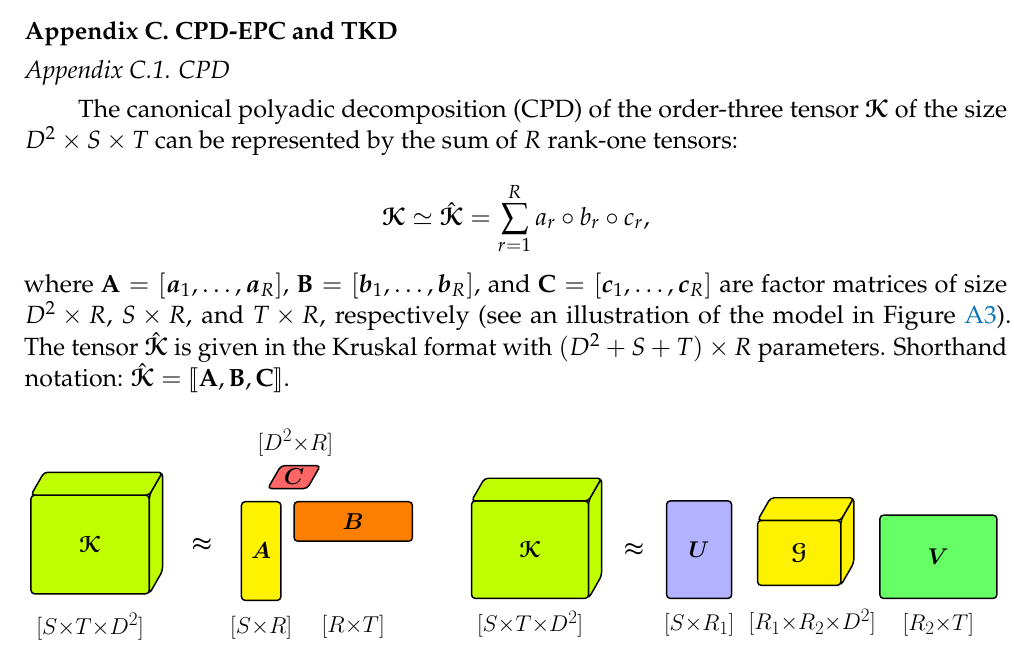
Figure A2. The mean and maximum are taken over channels for the MAE/cosine distance/bias between outputs of BN layers subsequent to the original and decomposed layers. Bias is the difference between outputs’ means. In the Single setting, the compressed model has only one decomposed layer, while in the Joint setting, three layers are simultaneously decomposed. W/O corresponds to the case without calibration of the BN statistics, while W corresponds to the case with calibration of the BN statistics. The X-axis shows the CP rank. Note: for the first decomposed layer, layer1.1.conv1 (left subfigure), the results of the Single and Joint settings coincide. ( a ) Mean of the MAE. ( b ) Mean of the cosine distance. ( c ) Maximum of the cosine distance. ( d ) Mean of the bias. ( e ) Maximum of the bias.